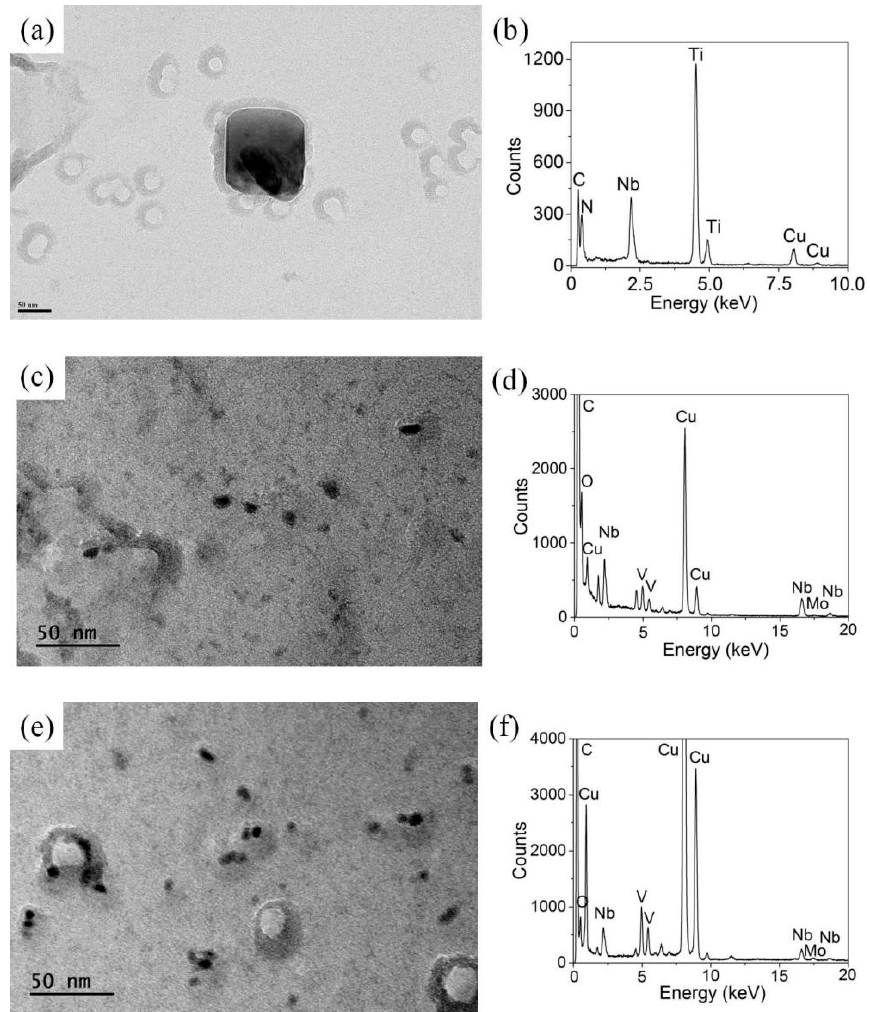
Figure 7. TEM images of the nanoprecipitates at different temperatures: ( a ) (Ti, Nb)N; ( c ) (Nb, V, Mo)C in the as-rolled state; ( e ) (Nb, V, Mo)C holding at 600 °C for 15 min; ( b , d , f ) the EDS of the precipitates in ( a , c , e ).